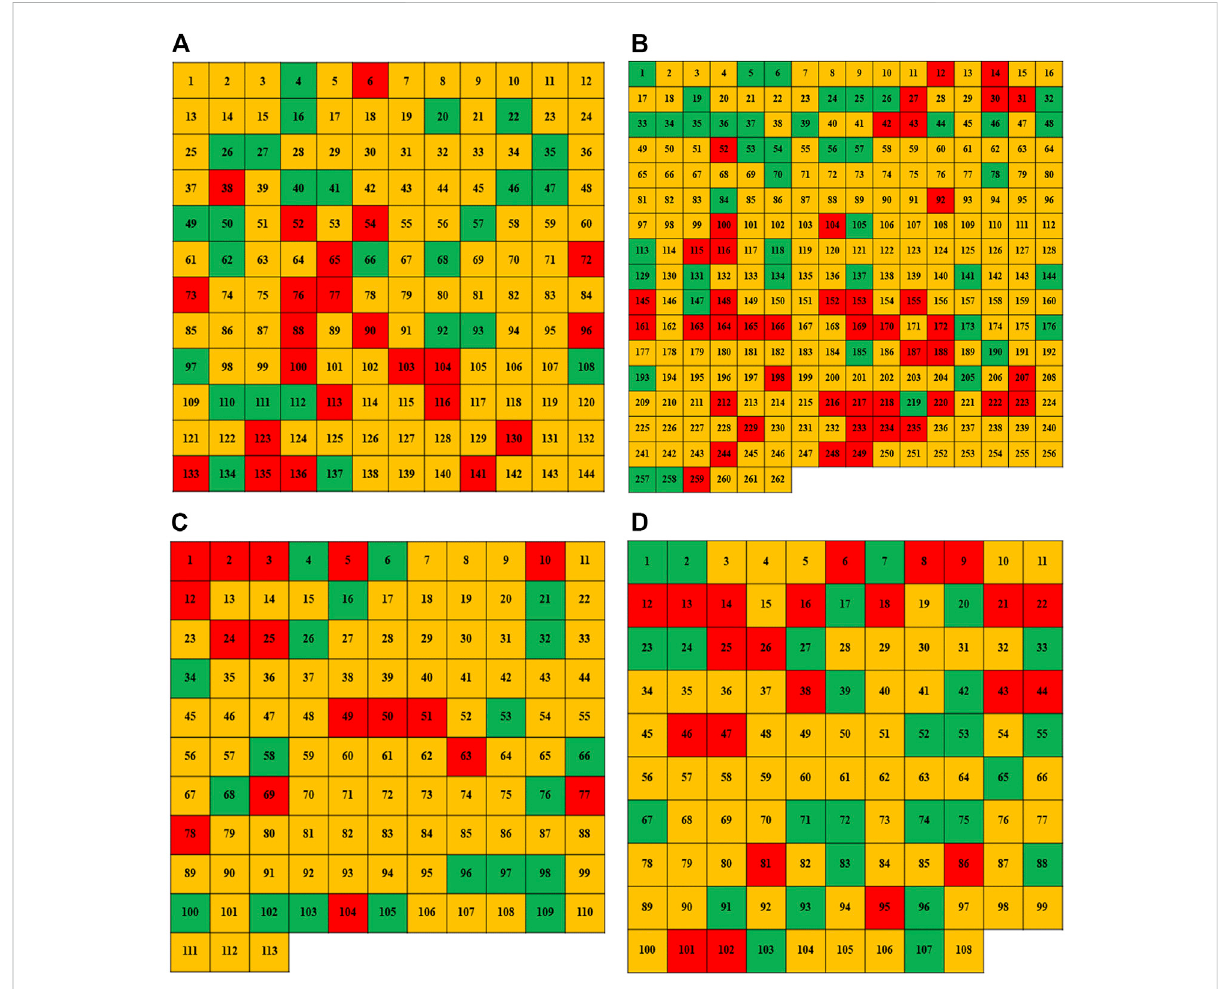
FIGURE 7 Results of enterprise classi fi cation in Tianning (A) , Wujin (B) , Xinbei (C) , and Zhonglou districts (D) . Colors in the squares represent the type of enterprise calculated by the EE – SBM – DEA model, the numbers in the squares are the serial numbers of all enterprises (Supplementary Appendix SA for the meaning of numerical serial number). Additionally, green indicates green enterprises, yellow indicates yellow enterprises, and red indicates red